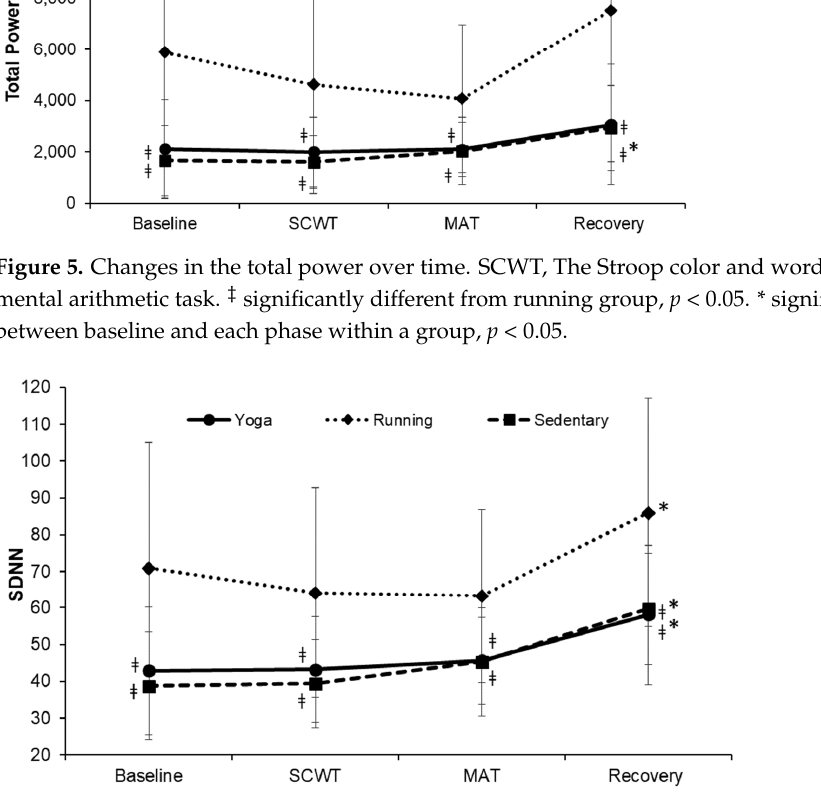
nificantly higher at the recovery (2938.33 ± 1660.10; p < 0.001) phase. However, compared